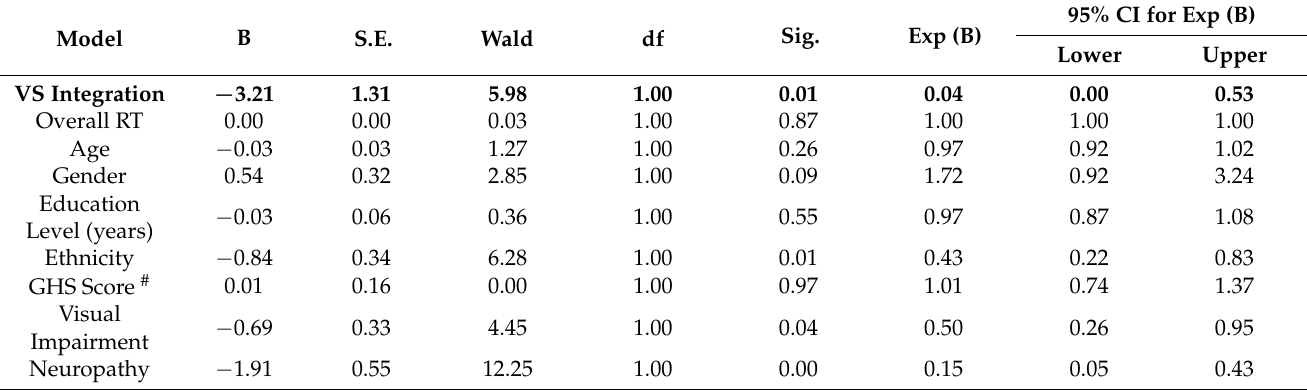
Table 2. Summary of fully adjusted logistic regression model for predicting diabetes status (diabetes vs. non-diabetes).